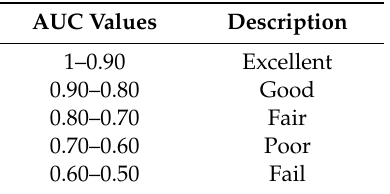
Table 4. Area under the curve (AUC) interval values with